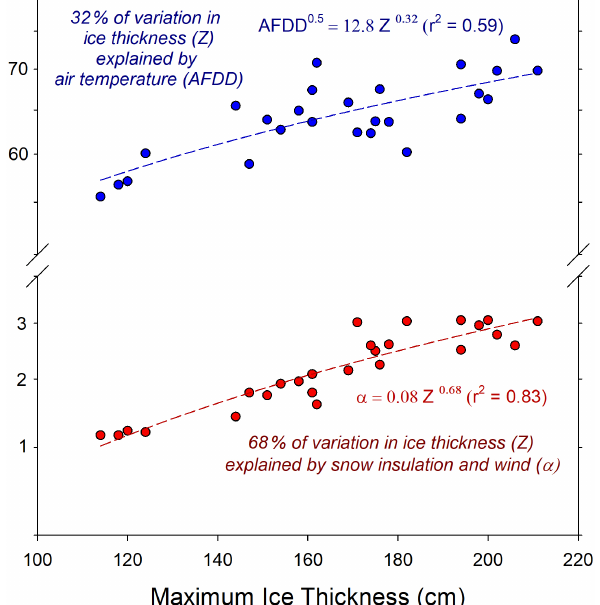
Figure 9. Example from Barrow Peninsula lake data using power law analysis partitioning of variation in MIT ( Z ) (Eqs. 3 and 4) balanced between air temperature (AFDD) and snow insulation ( α ).